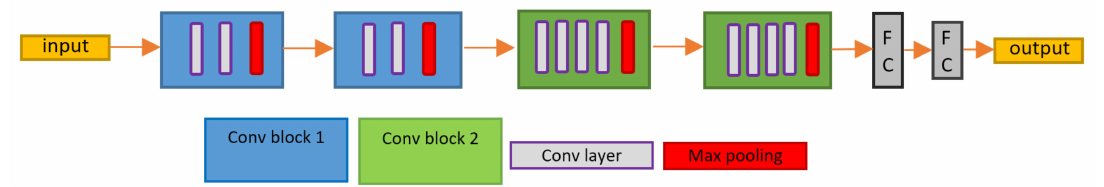
Figure 5. Customized CNN (Convolutional Neural Network)